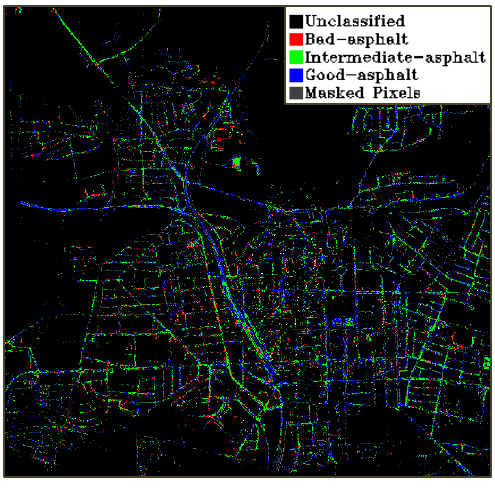
Figure 10. Classification result for the whole study area.